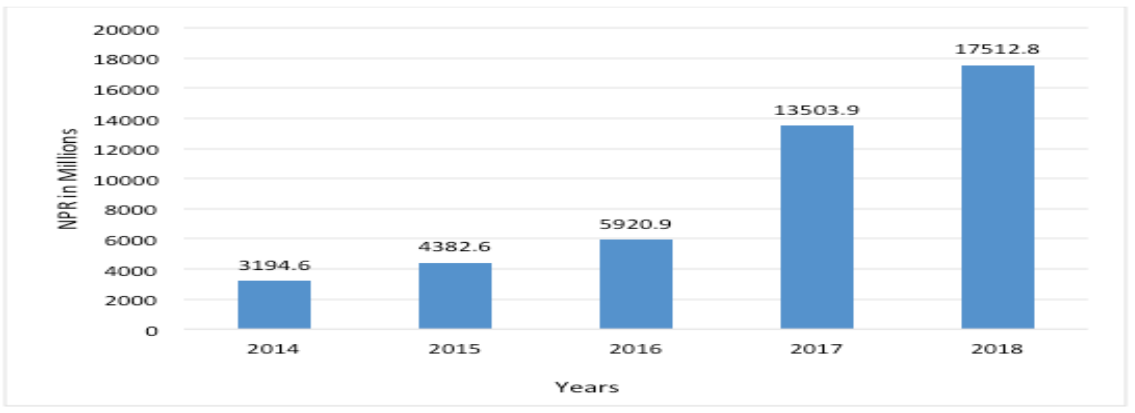
Figure 1: FDI in Nepal (NPR in